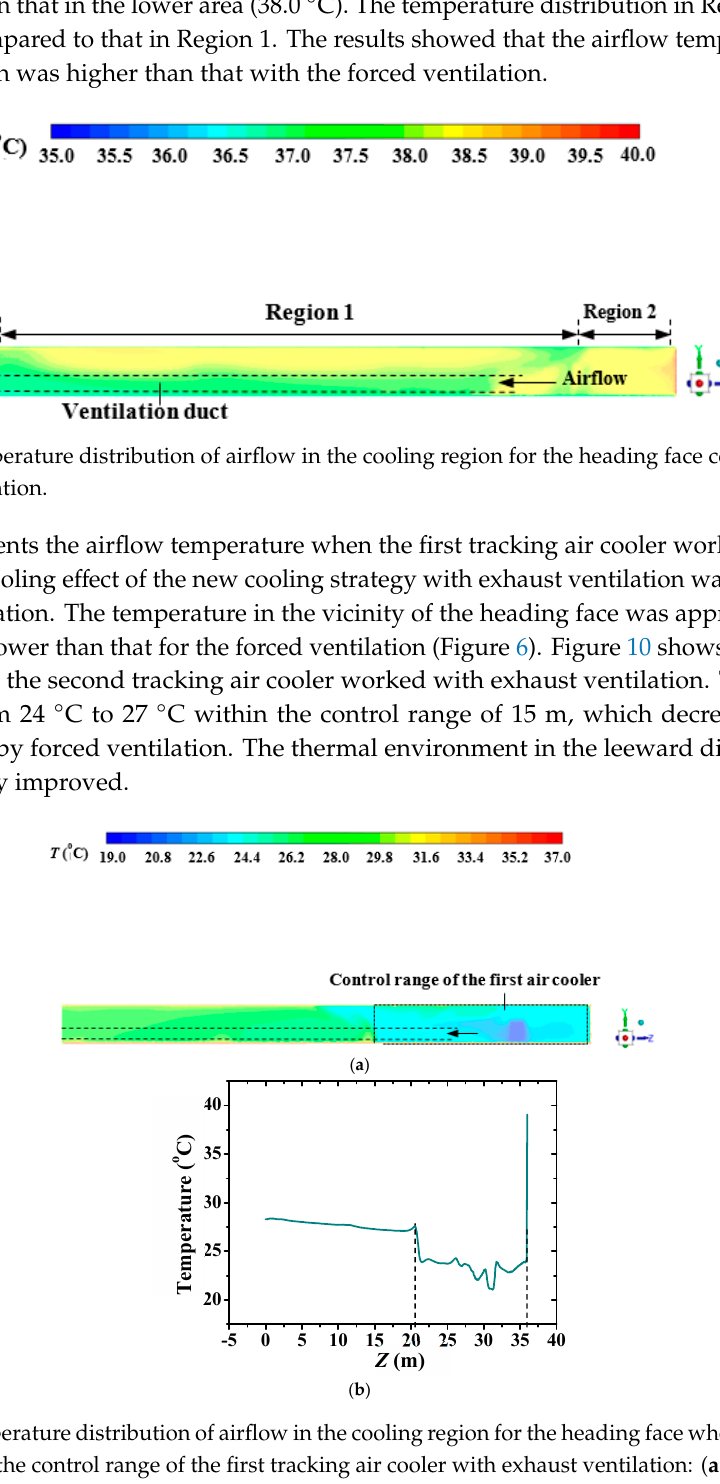
-5 0 Figure 9. Temperature distribution of airflow in the cooling region for the heading face when the worker was located in the control range of the first tracking air cooler with exhaust ventilation: ( a ) temperature contour at the plane of X = 1.25 m; ( b ) variation of the temperature with the Z axis at the line of X = 1.25, Y = 1.5 m.